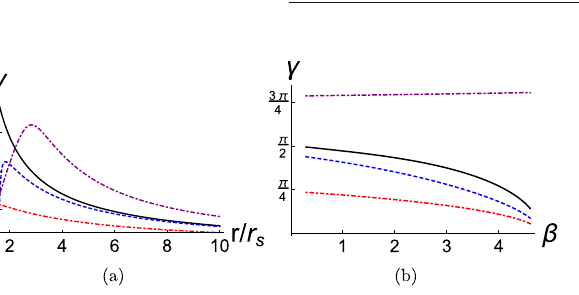
Fig. 7 The angle γ of the RN black hole as a function of the radial Fig. 5 The angle γ as a function of the radial distance r / r S of the distance r / r p .Theinnerhorizon r m issetto r m = 0 . 5 r p .Theblacksolid observer or the parameter β in the plasma model with r B = 0 . 5 r S . The line, blue dashed line, red dot dashed line, and purple dot dashed line black solid lines, blue dashed lines, red dot dashed lines, and purple dot correspond to the static observer, surrounding observer, freely falling dashed lines correspond to the static observer, surrounding observer, observer,andescapingobserver,respectively. a Withoutplasma. b With freely falling observer, and escaping observer, respectively. a The angle γ as a function of the radial distance r / r S for four kinds of observers with β = 1. b The angle γ as a function of the parameter β with the observers located at r = 3 r S